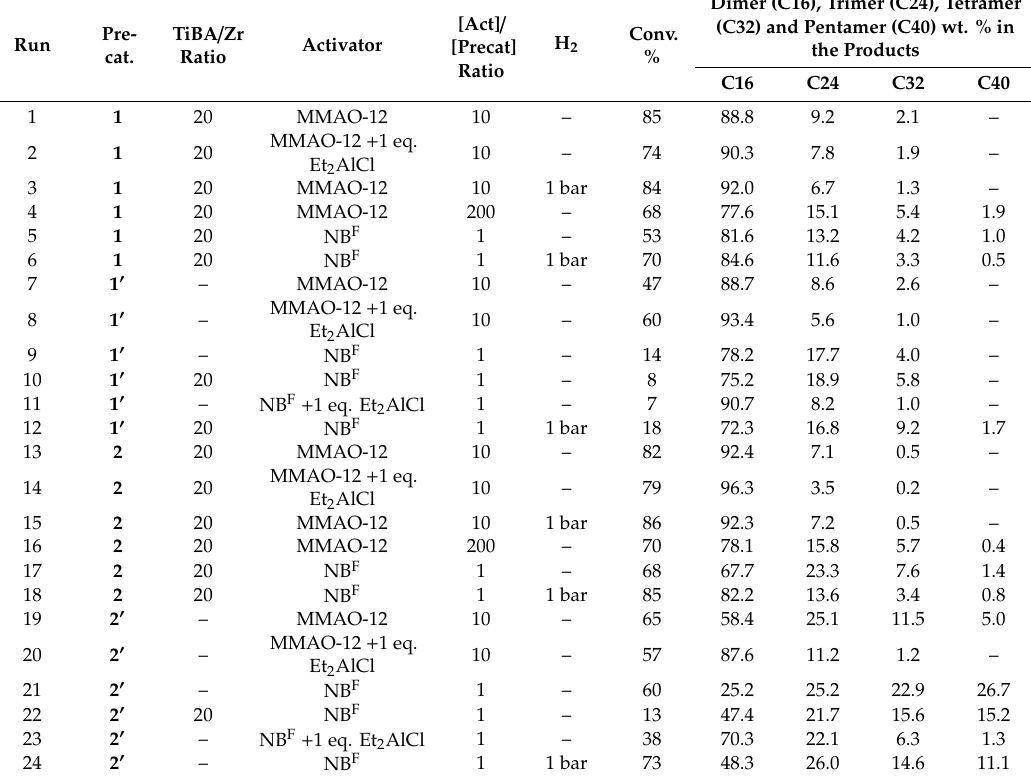
Table 1. Results of 1-octene oligomerization